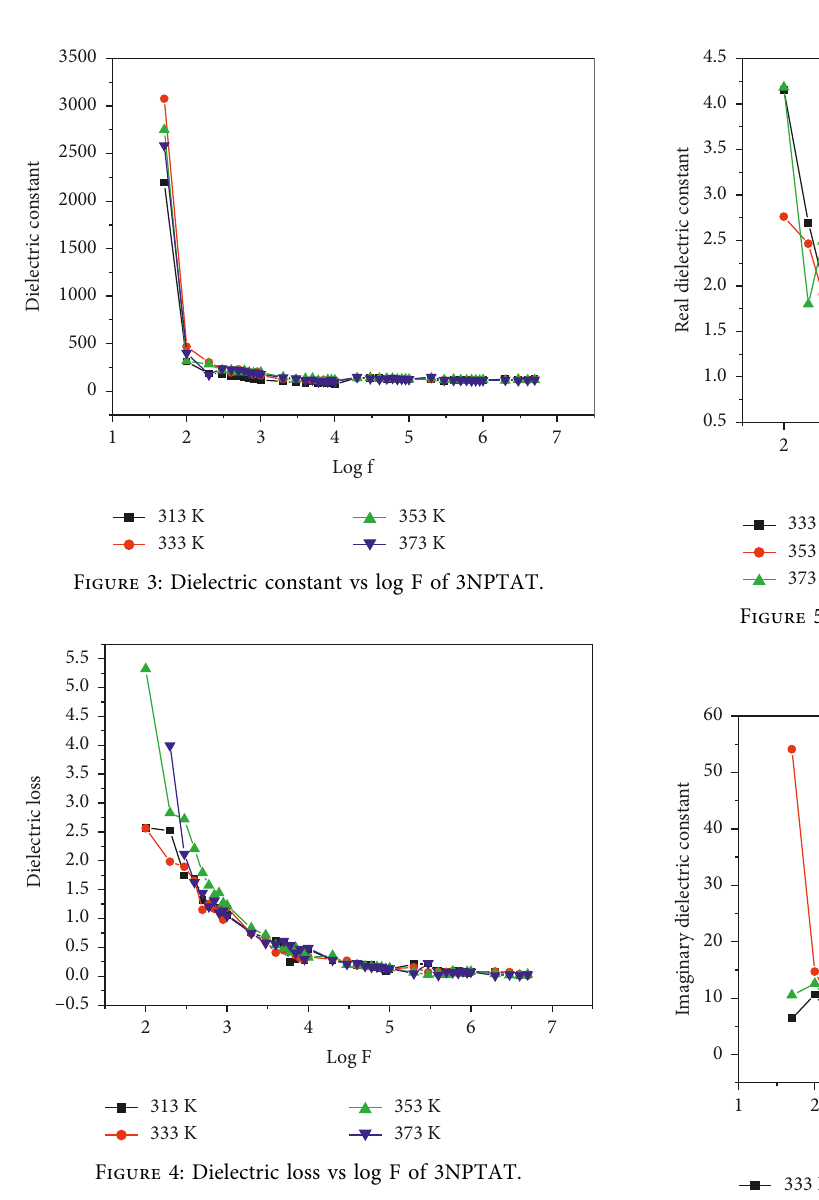
Figure 2: Reaction mechanism of the grown crystal of 3NPTAT.